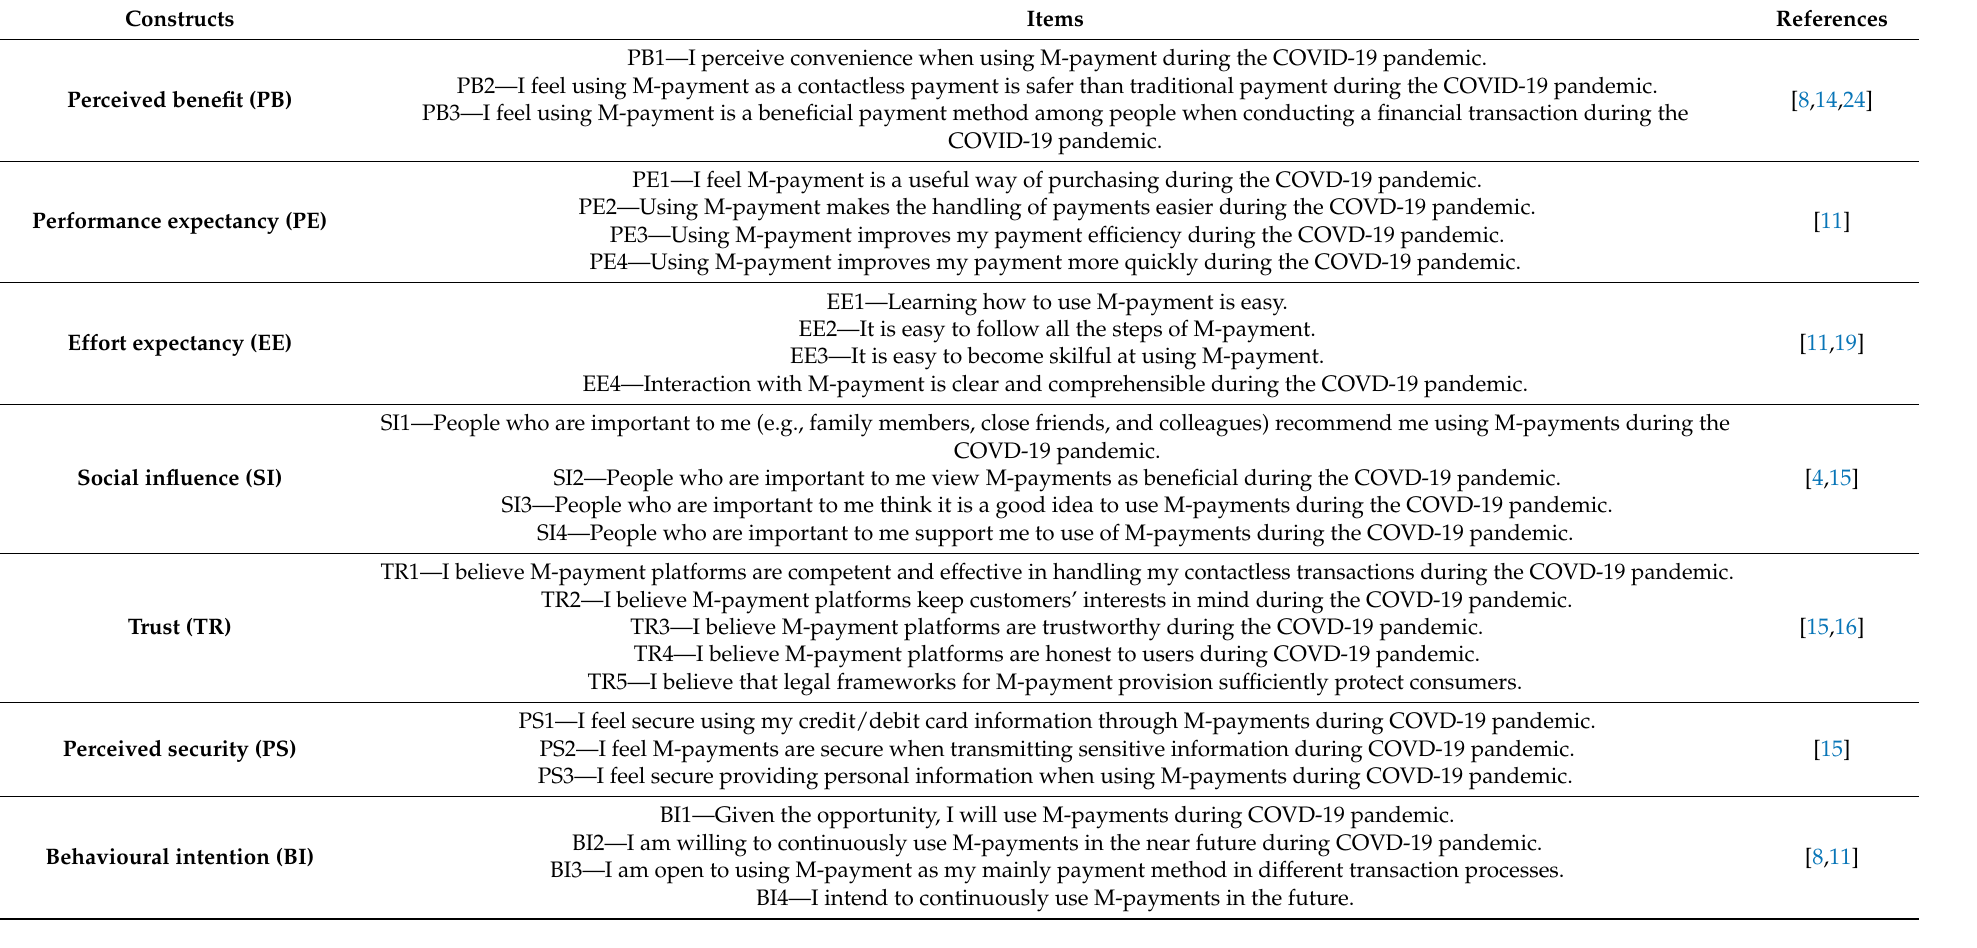
Table A1. Questionnaire with constructs, items and